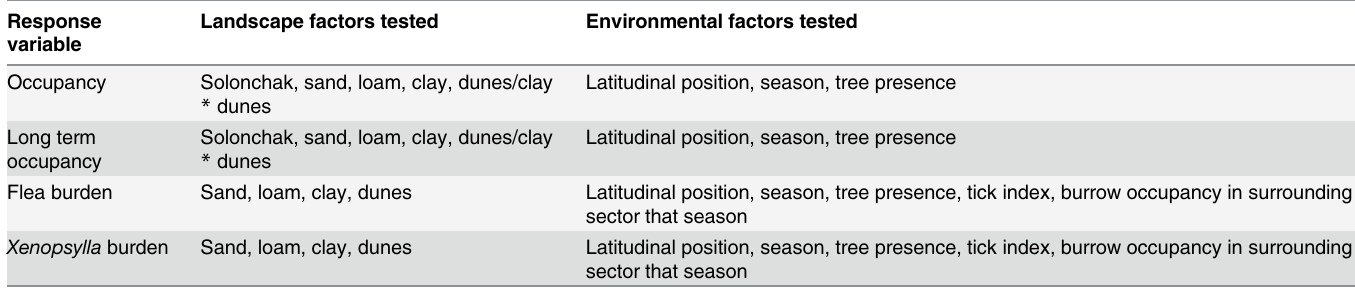
Table 2. Landscape factors and further environmental factors tested in each model.